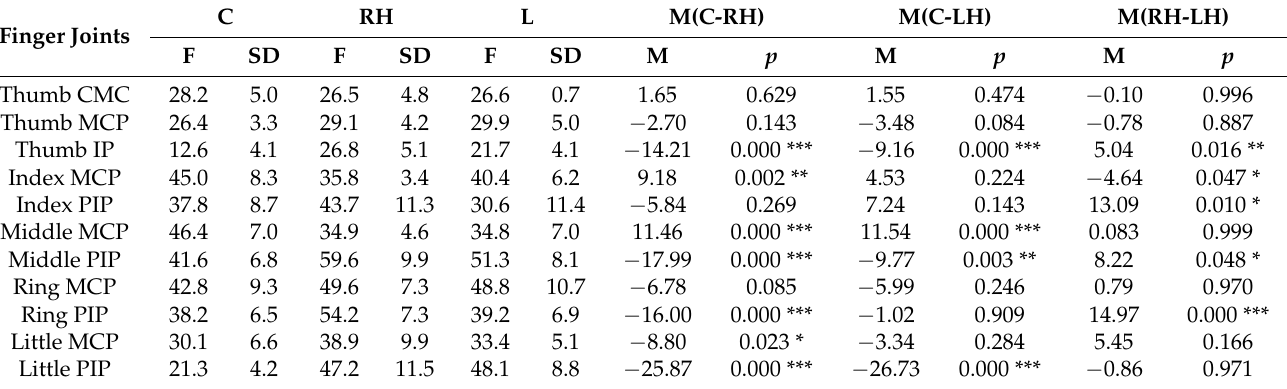
3.2. Range of Motion of the Finger Joints in the Stroke Group with Right Hemiparesis Mean and standard deviation values of the range of motion (ROM) and the total arc of motion (aROM) of each finger joint in the control and the stroke group with right hemiparesis (RH) are shown in Table 4. As reported in Table 5, the extension angles of the Thumb CMC, Index MCP, Middle MCP joints in the control group were significantly